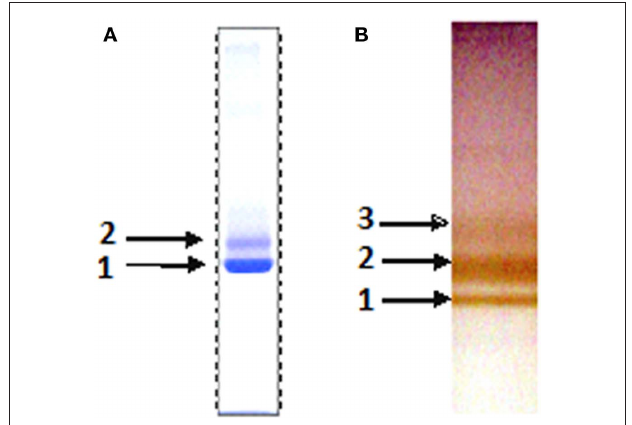
Figure 4 | Native polyacrylamide electrophoresis of purified samples from (A) D. vulgaris Dvir stained with Coomassie and (B) D. norvegicum Drub